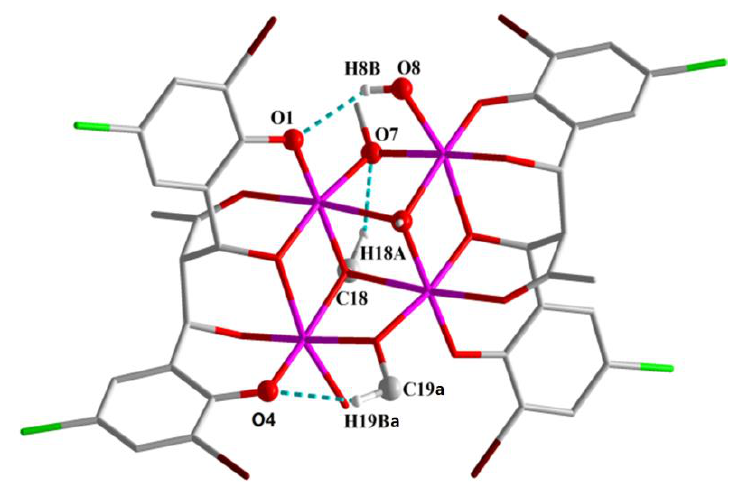
Figure 9. Part of intramolecular C–H···O hydrogen-bonding interactions in Mn III complex 2 (symmetry codes: a = 1 − x, 1 − y, 1 − z).